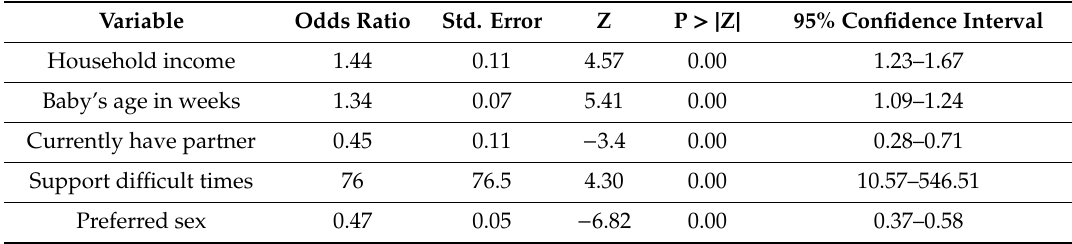
Table 4. Logistic regression for the variables associated with postnatal